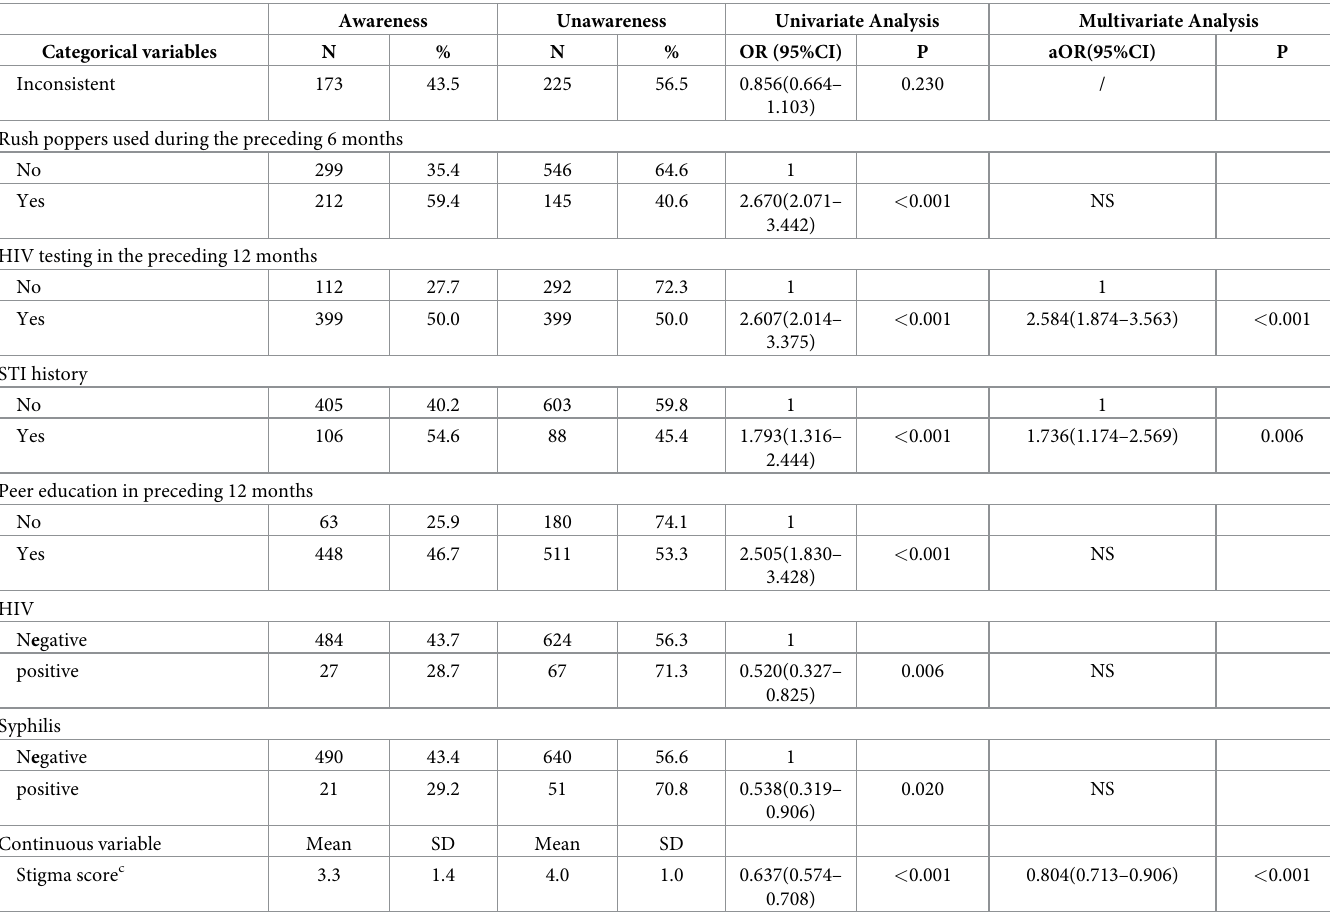
CI: 2.014–3.375, P < 0.001), (10) infection with an STI (OR: 1.793, 95% CI: 1.316–2.444, P < 0.001), and (11) participation in peer-education programs on HIV prevention in the